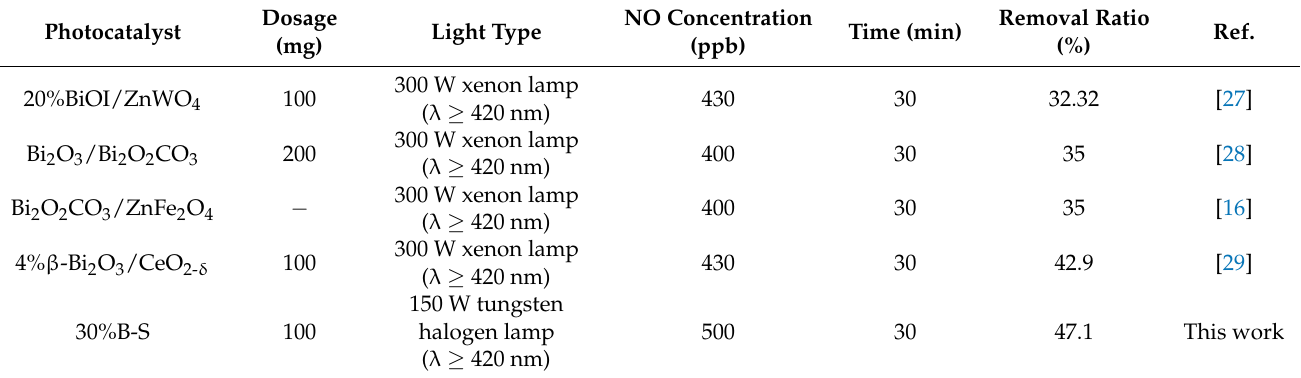
Figure 3. XRD patterns of BiOI, SnO 2 , and X %B-S (where X = 15, 30, and 75).